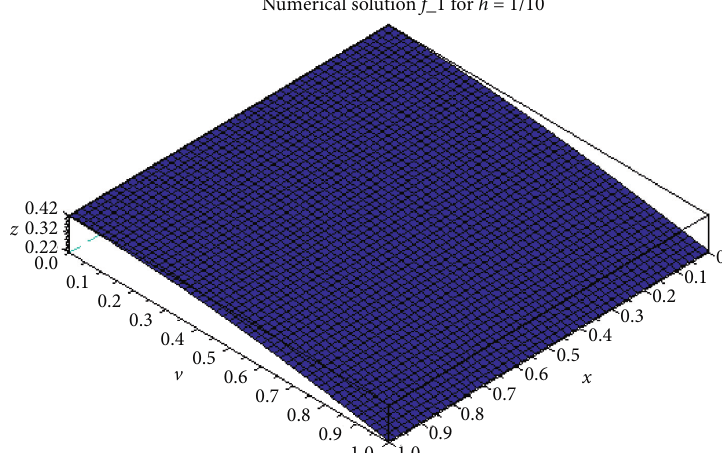
Figure 1: Numerical solution f 1/10